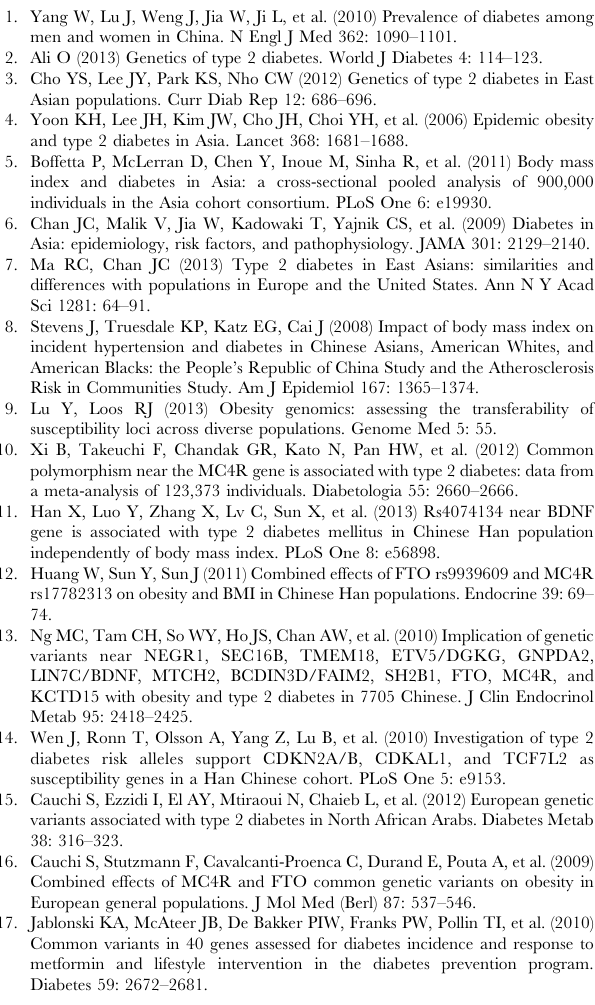
Table S1 Information of genotyped SNPs. Abbreviations: SNP, single nucleotide polymorphism; Chr, chromosome; T2D, type 2 diabetes; EU, European; HB, Han Chinese; BMI, body mass index; WHR, waist-hip ratio; WC, waist circumference. a. Risk allele for obesity is underlined. b. Genotype distributions are shown as the counts of three genotypes (bb, Bb, BB). B, major allele; b, minor allele. Table S2 The joint effects of obesity-related SNPs on glycemic quantitative traits in control subjects. Abbreviations: OGTT, oral glucose tolerance test; ISIm, Matsuda index; BMI, body mass index; WC, waist circumference. All non-Gaussian distributed quantitative traits in the control group were natural logarithmi- cally transformed to normalize distributions. b value is reported for genotype risk score in multivariable regression models: model 1, adjusted for age and sex; model 2, adjusted for age, sex and BMI; model 3, adjusted for age, sex, BMI and